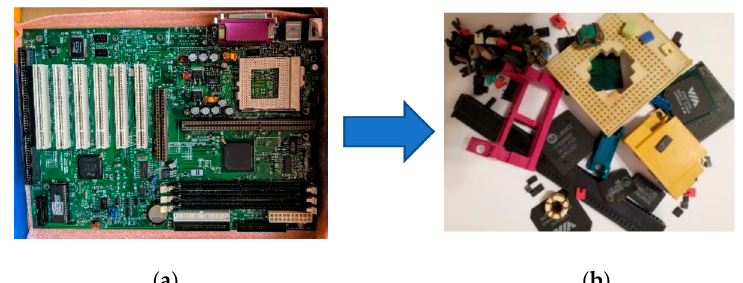
Figure 1. Remaining components after the dismantlement process of PCBs. ( a ) Personal Computer Motherboard; ( b ) Components remaining after the dismantlement process of a motherboard.